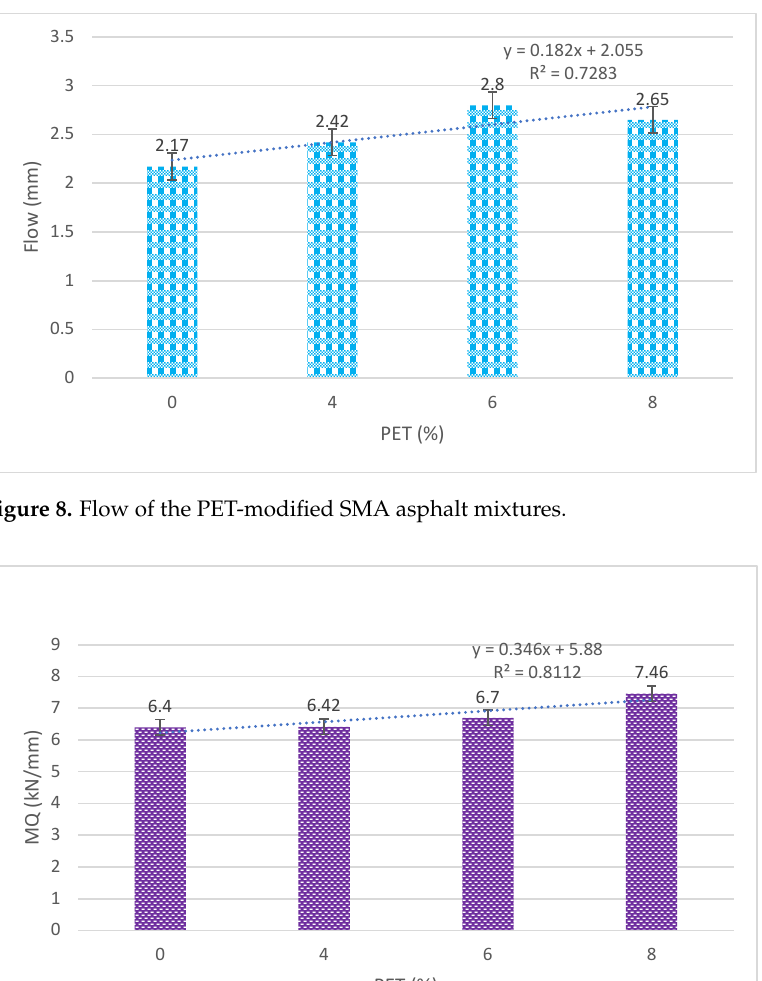
Figure 7. Stability of the PET-modified SMA asphalt mixtures.